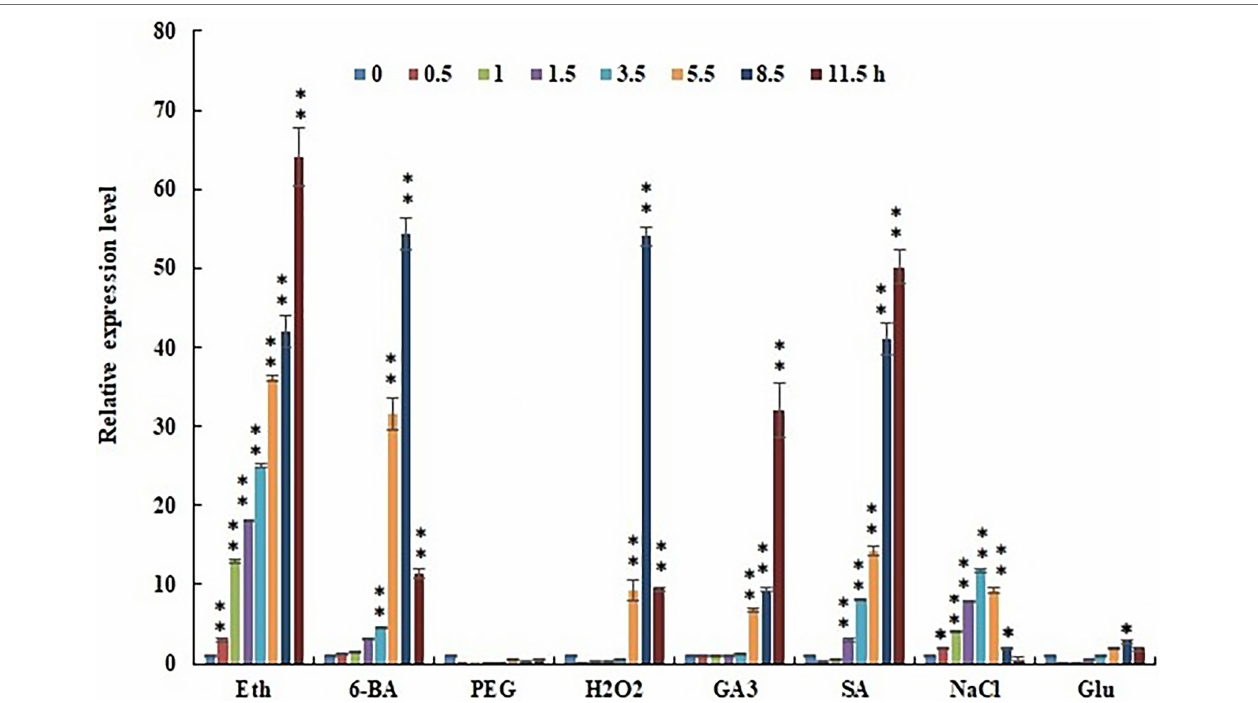
FIGURE 5 | Effect of elicitors (Eth, 6-BA, PEG, H 2 O 2 , GA 3 , SA, NaCl, and Glu) on CcERF2 expression. The 24 DAP pepper fruits were treated with elicitors (Eth, 6-BA, PEG, H 2 O 2 , GA 3 , SA, NaCl, or Glu), and the fruit were sampled after elicitation for 0.5, 1.0, 1.5, 3.5, 5.5, 8.5, and 11.5 h. Without induction at the 0 h time point was used as control expression. The experiments were replicated three biological times and three technical times. Data are expressed as the mean ± SD ( n = 9). Student’s t -test was used to identify significant differences compared to the control ( * p < 0.05, ** p <